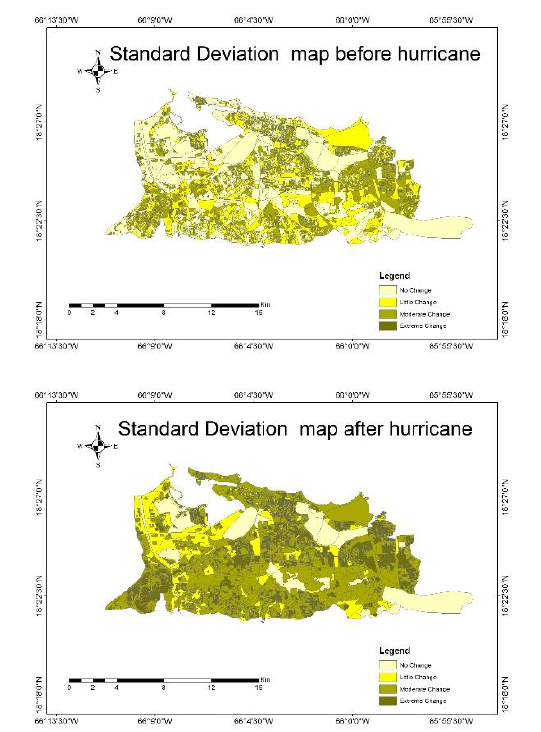
Figure 5: Standard deviation maps for Puerto Rico before and after the